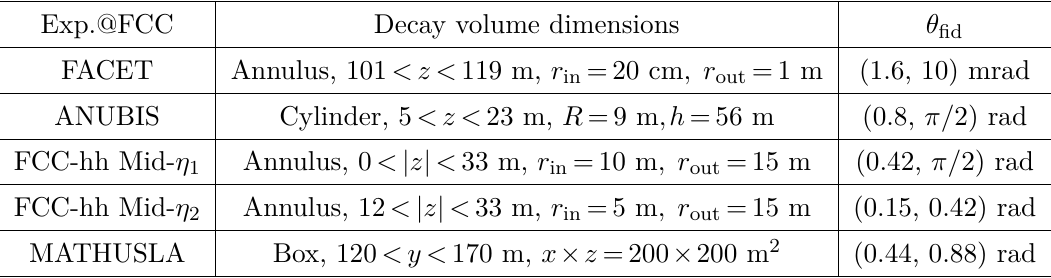
Table 1 . Parameters of FCC-hh-based experiments considered in this